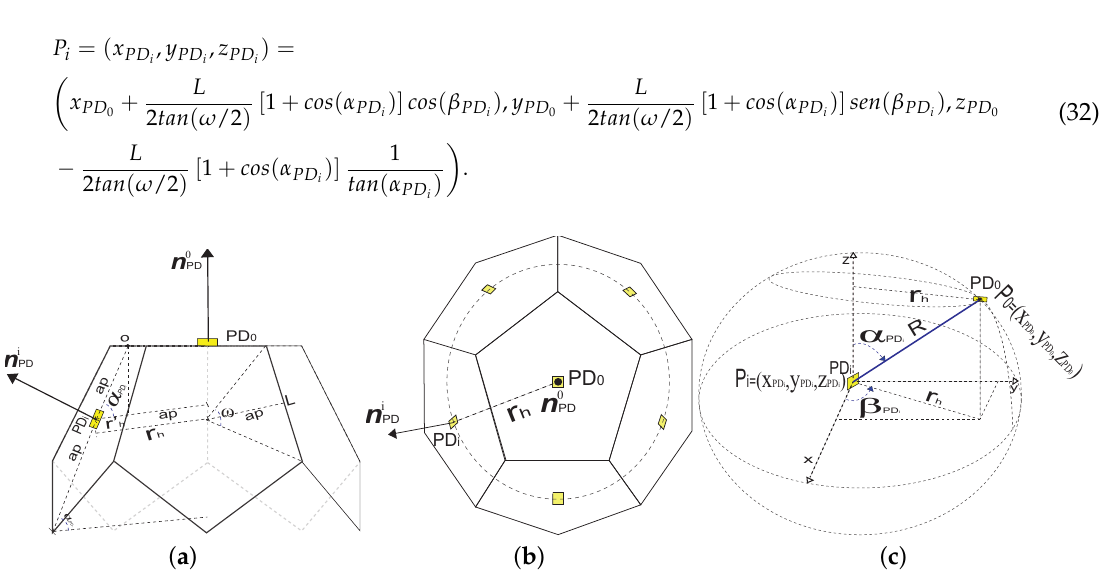
Figure 6. General structure of the hemi-dodecahedron ADR. ( a ) Side view, ( b ) top view, and ( c ) coordinate system of the